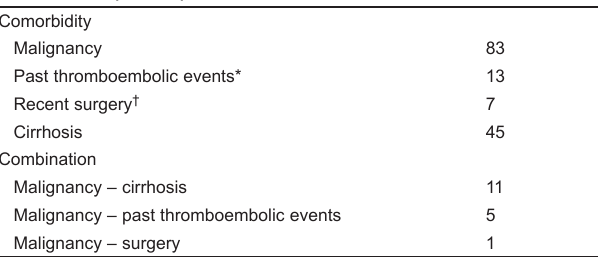
TABLE 3 Pharmacological anticoagulation during hospital stay Antiplatelet